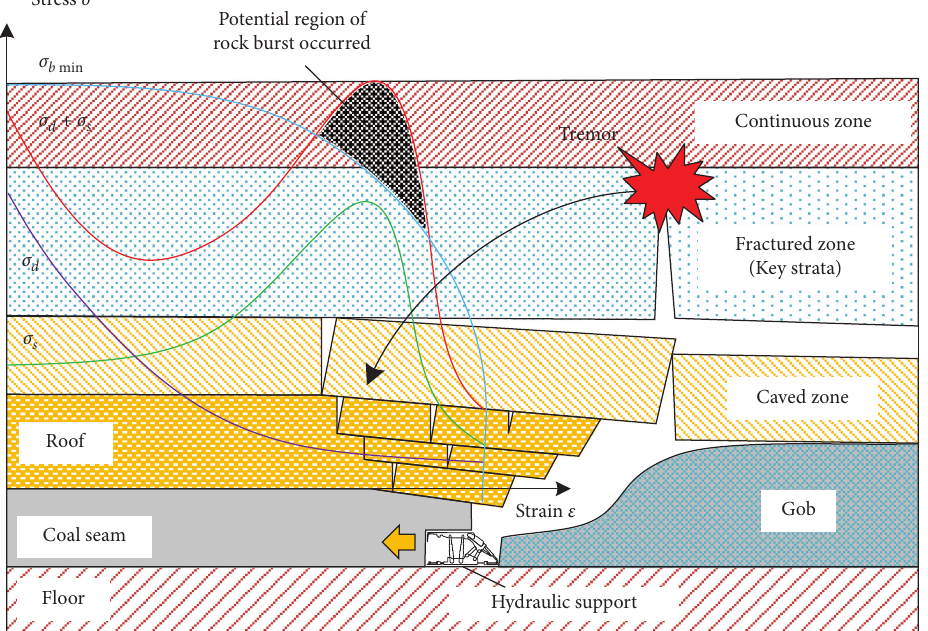
Figure 1: Schematic diagram of hard-roof rock bursts